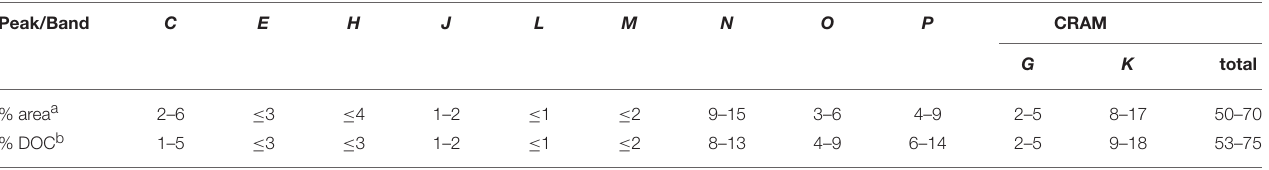
TABLE 3 | Relative peak intensities observed in spectra acquired on the 400 MHz instrument.